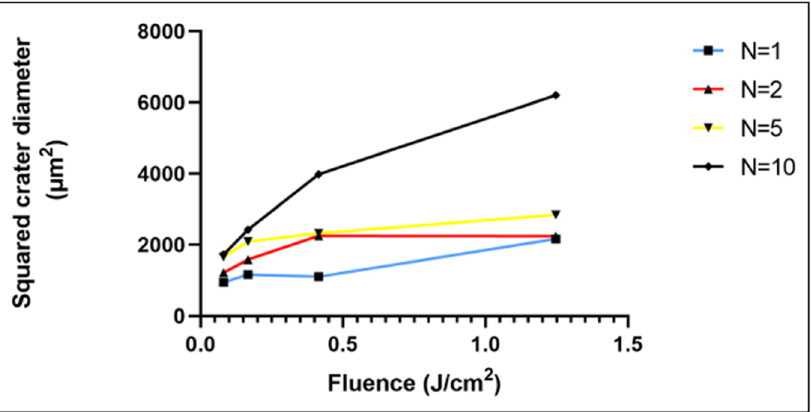
Figure 3. Increase in laser crater diameter with rising laser fluence and applied laser pulses.